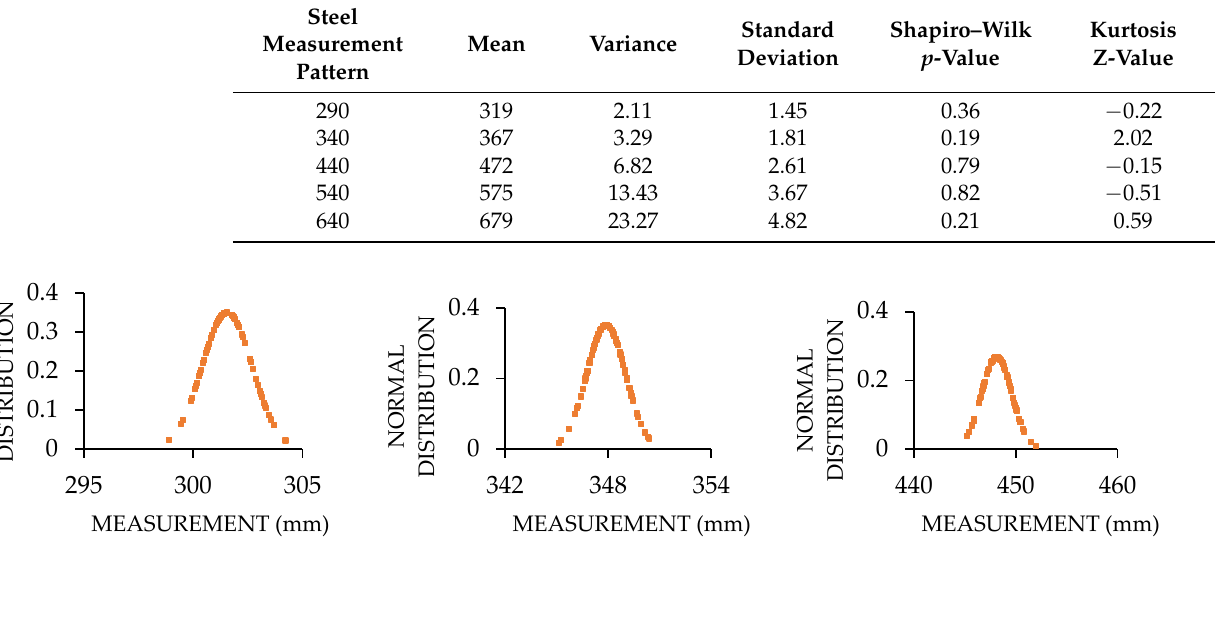
Table 5. Statistical analysis of VL53L0X for tests with no excessive ambient light.